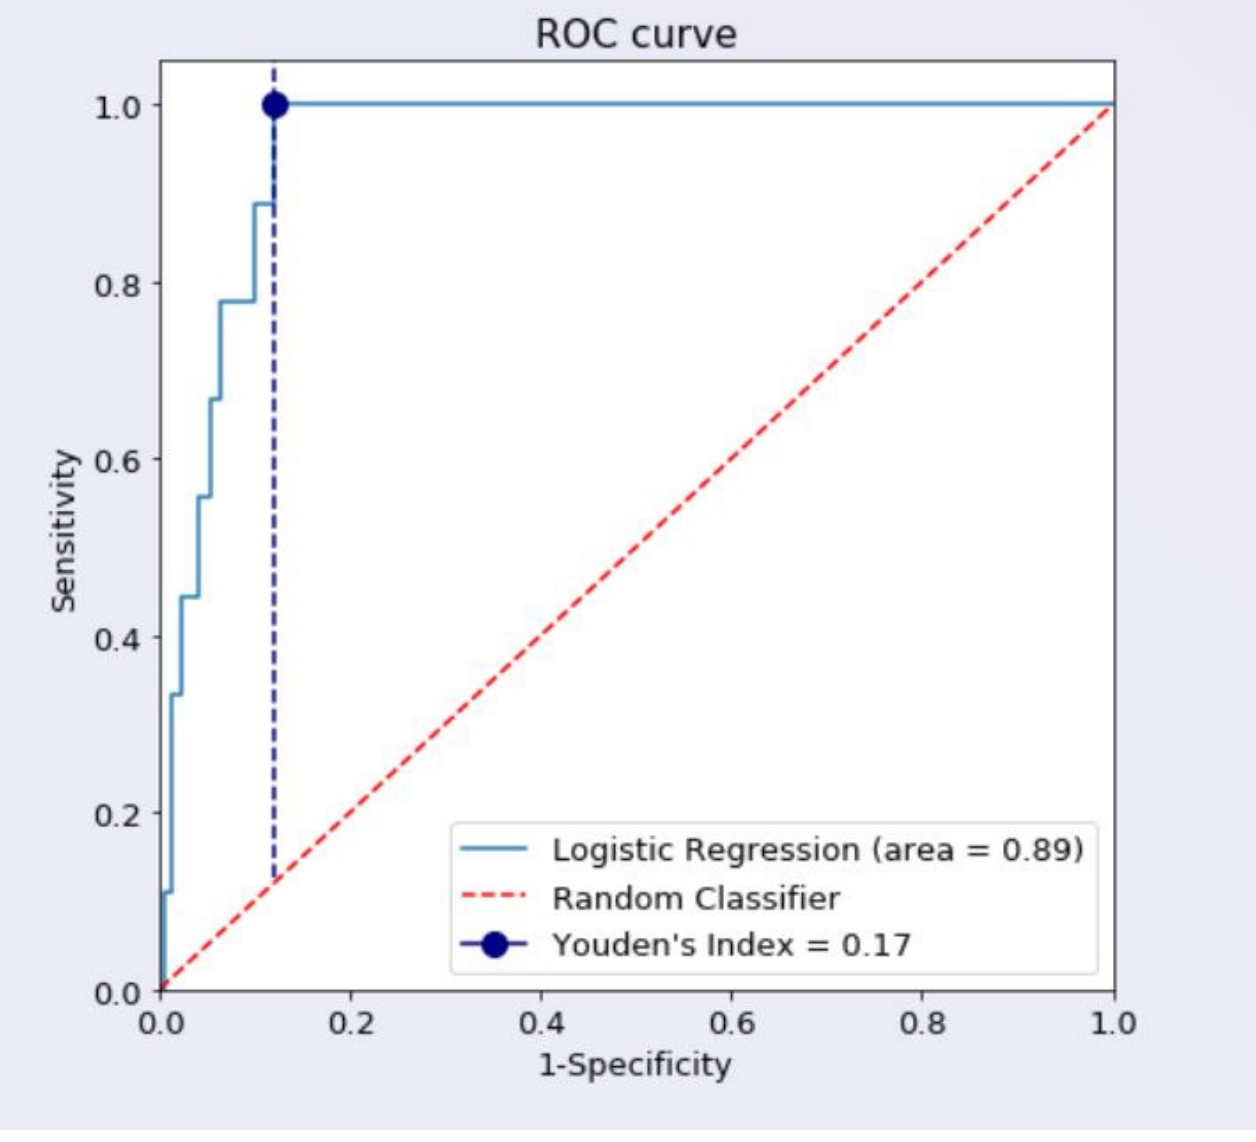
Figure 1. ROC curve that plots the trade-off between the sensitivity and specificity of the logistic